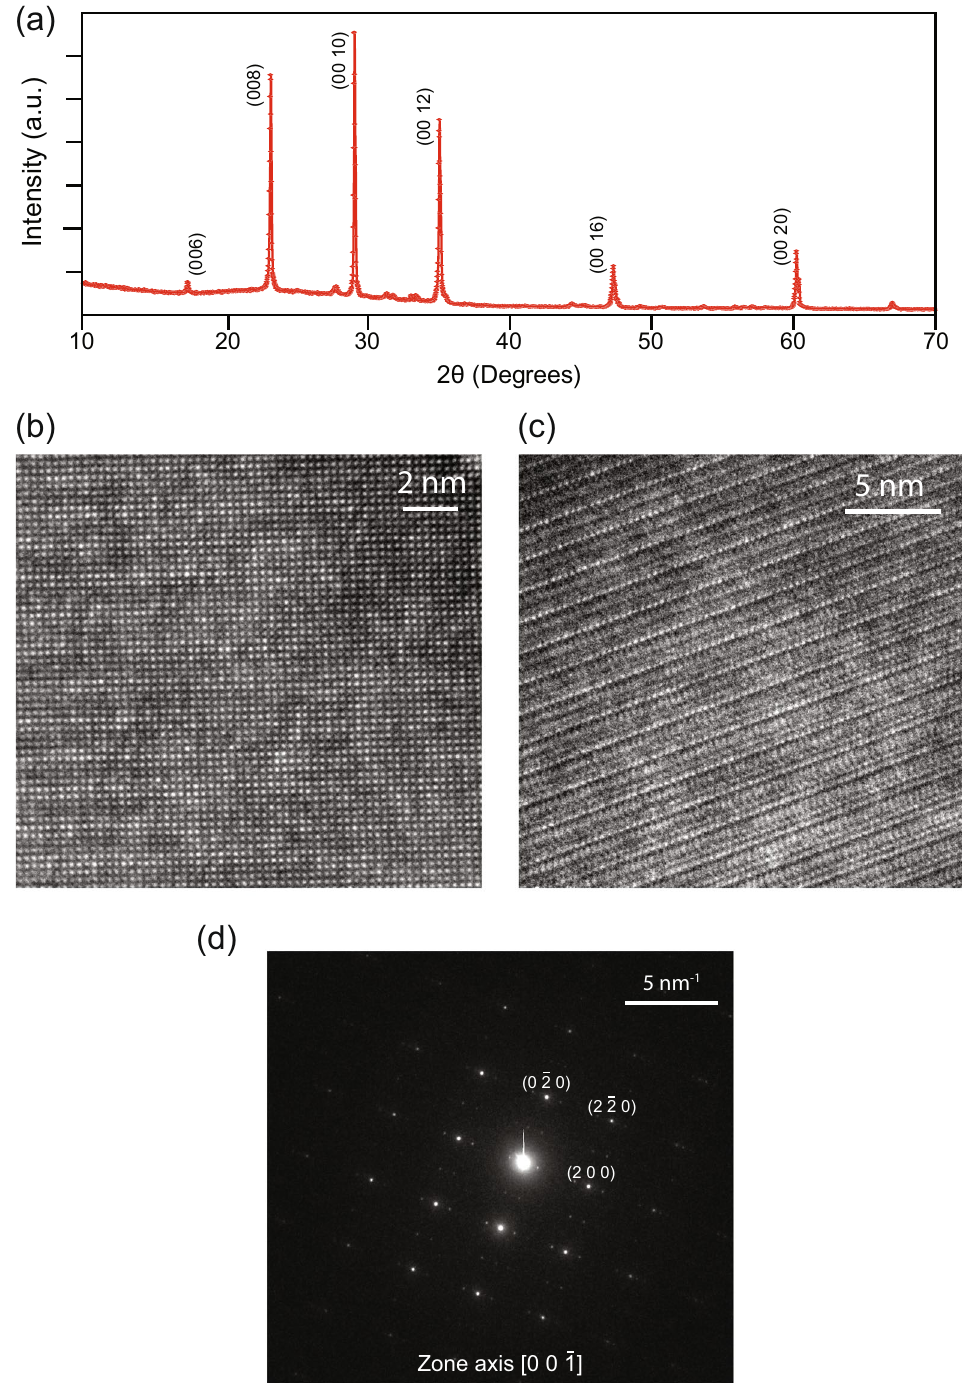
Figure 2. Structural characterization of BSCCO whiskers. ( a ) Powder x-ray diffraction pattern of BSCCO whiskers. The powder diffraction pattern shows (00 l ) plane as the preferred orientation, where the thickness of the whisker corresponds to c -plane. ( b ) HRTEM of BSCCO whiskers with incident beam parallel to c -axis. ( c ) Cross-sectional TEM with incident beam perpendicular to c -axis. Periodic lines at interval of 1.52 nm are visible. ( d ) Electron-beam diffraction with incident beam parallel to c -axis. HRTEM and electron-beam diffraction data suggest high crystalline quality of the